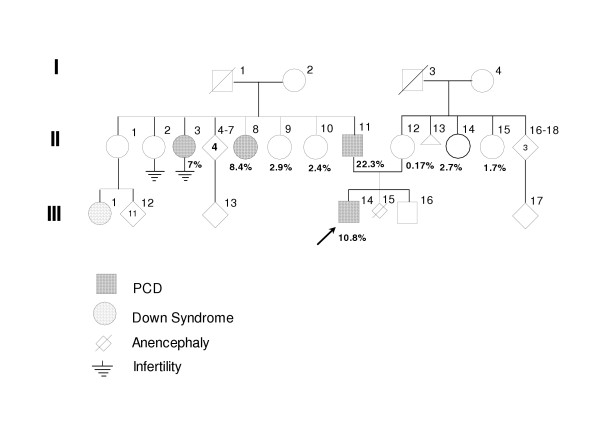
Pedigree of the family. PCD frequencies and familial data of investigated individuals are indicated.